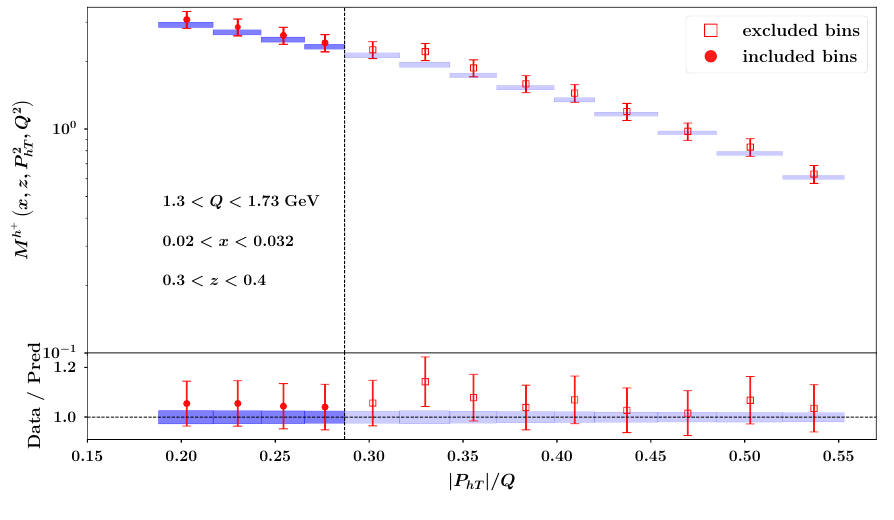
Figure 18 . Comparison between COMPASS multiplicities and theoretical results for the SIDIS production of unidentified positively charged hadrons off a deuteron target at 1 . 3 < Q < 1 . 73 GeV, 0 . 02 < x < 0 . 032 and 0 . 3 < z < 0 . 4 as a function of for baseline fit at 68% CL, empty squares for data points not included in the baseline fit. Lower panel: ratio between experimental data and theoretical